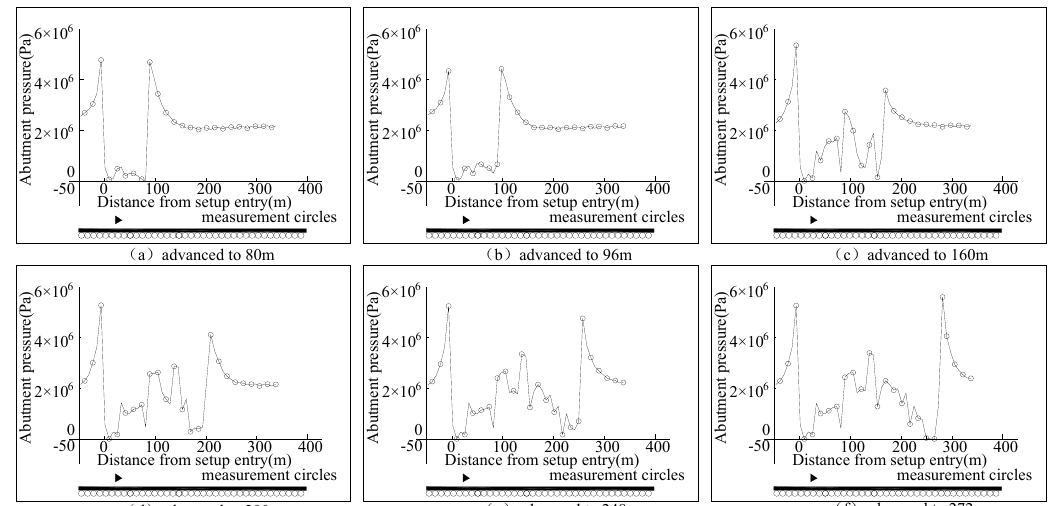
Figure 7. Distribution of support pressure.